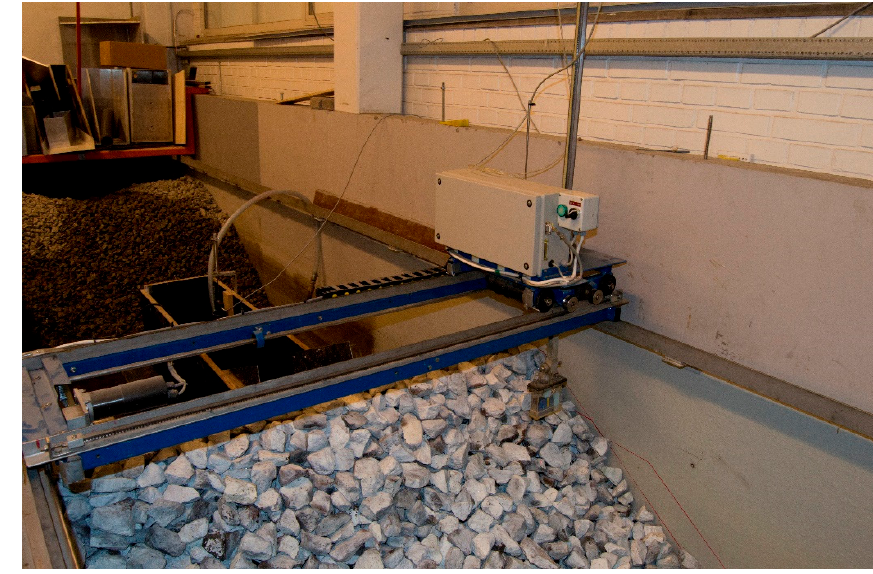
Figure 7. Profiler used to measure the eroded area.